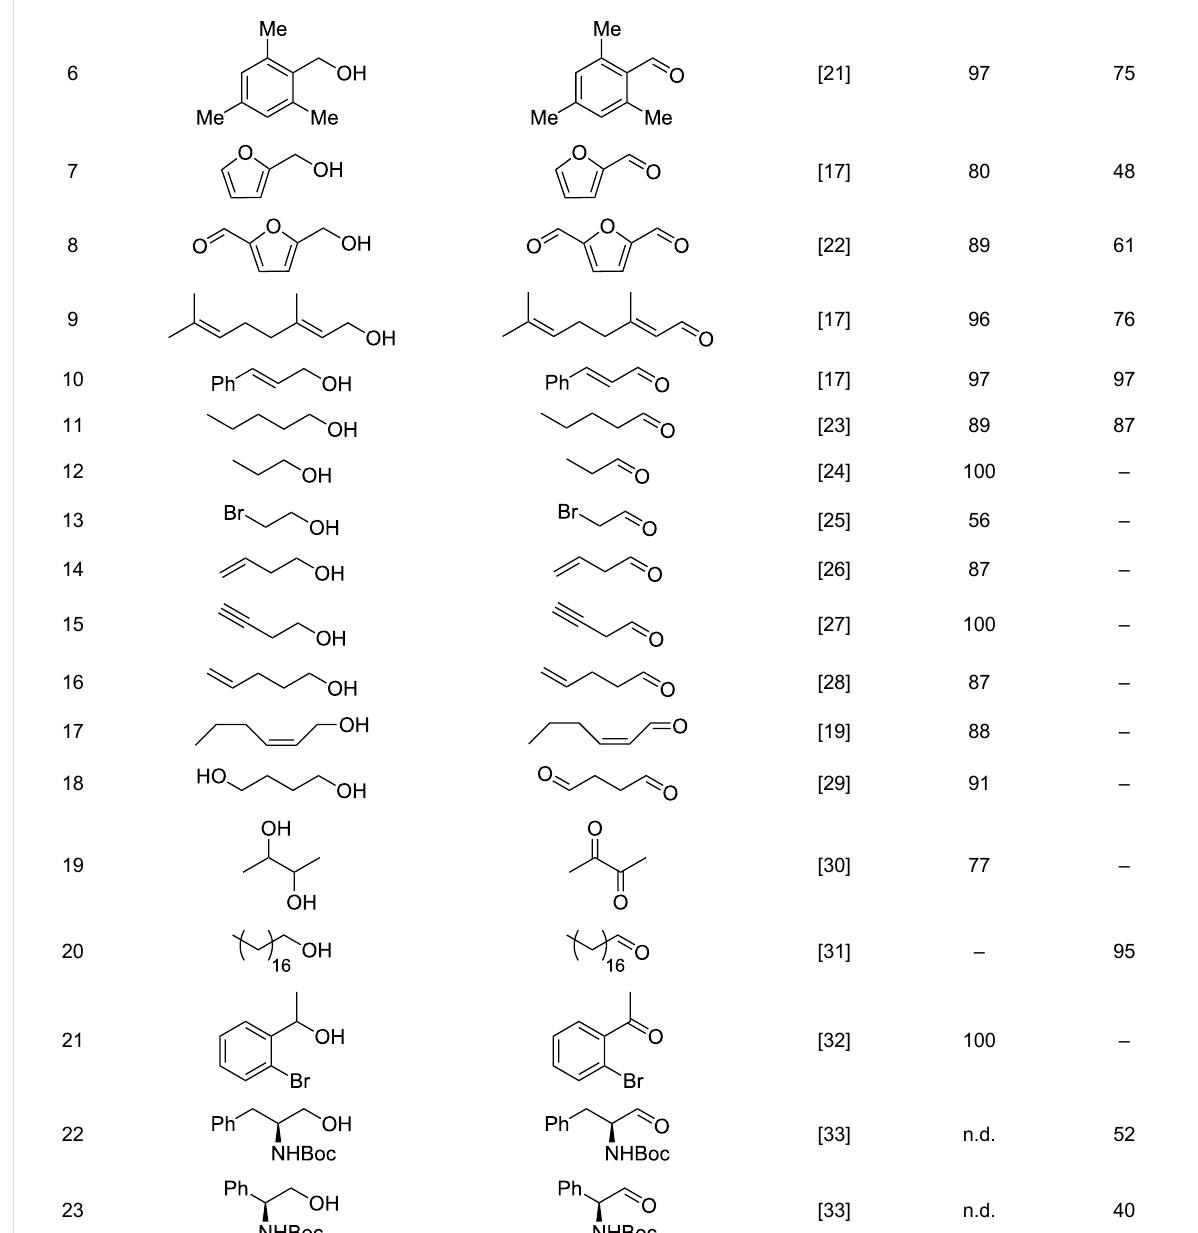
Table 1: Products and yields in the oxidation of alcohols performed in a tubing reactor at a total flow rate of 0.4 mL/min (residence time: 4.5 min) at 35 °C.